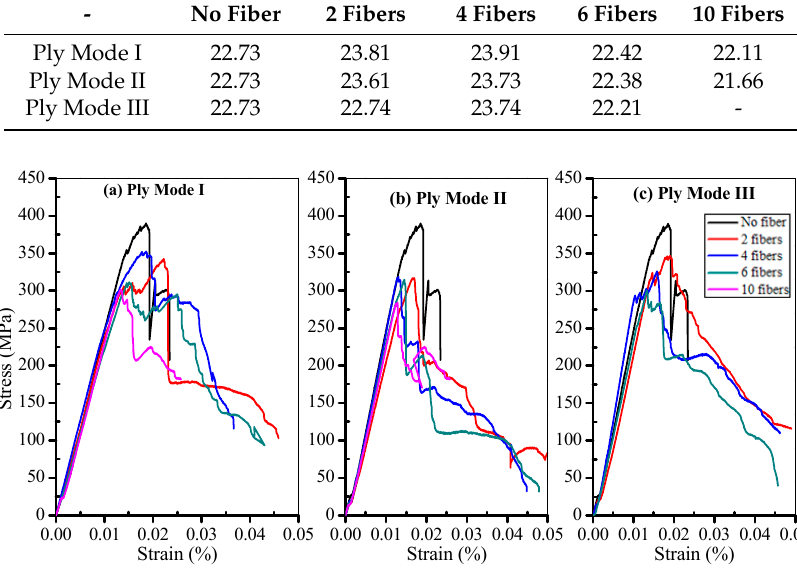
Figure 5. Comparison of the flexural stress–strain curves of SMA composites.